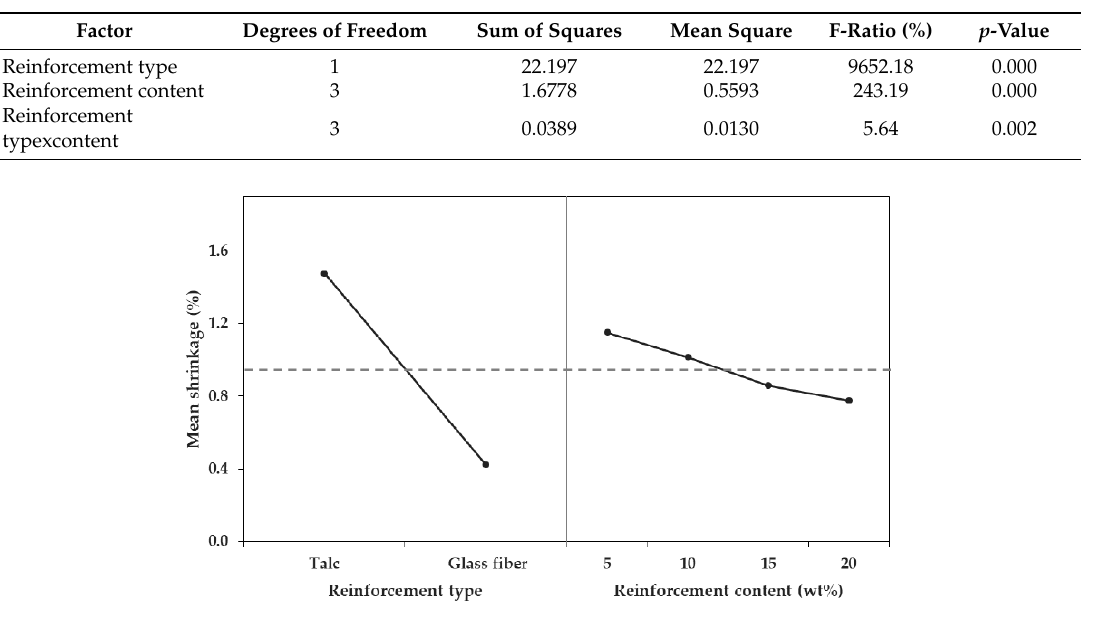
Table 6. Two-way ANOVA of shrinkage in the flow direction.